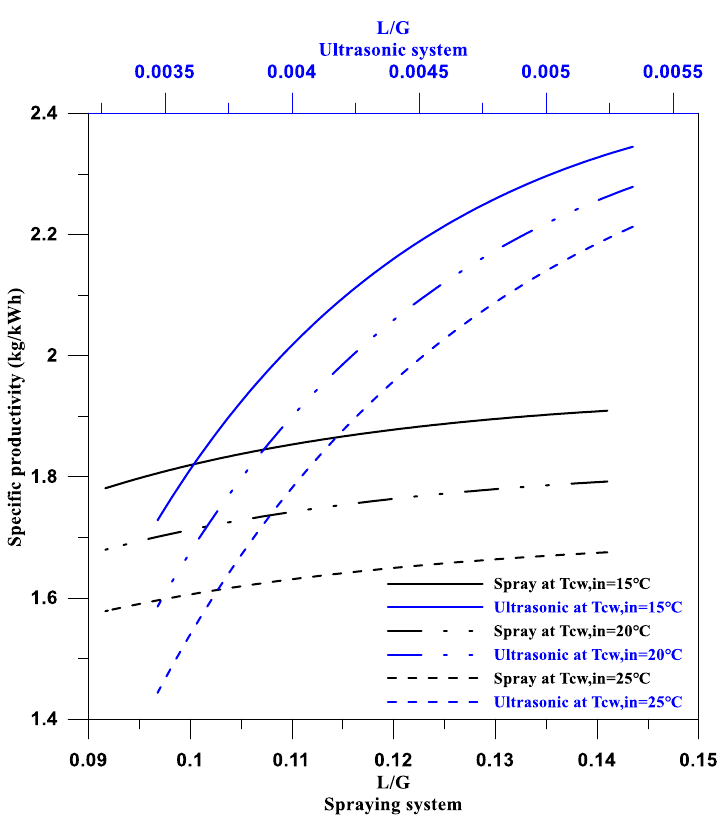
ff erent T cw,in . Water 2020 , 12 , x FOR PEER REVIEW